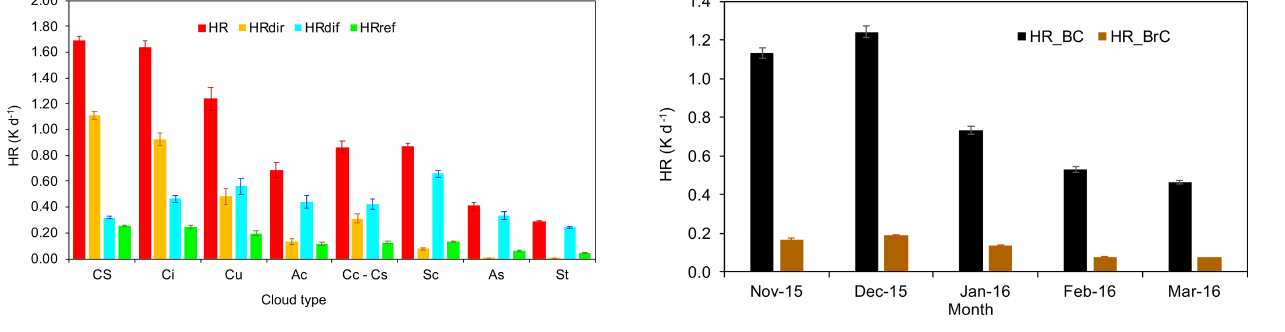
Figure 14. Monthly averaged data for the HR of both BC and